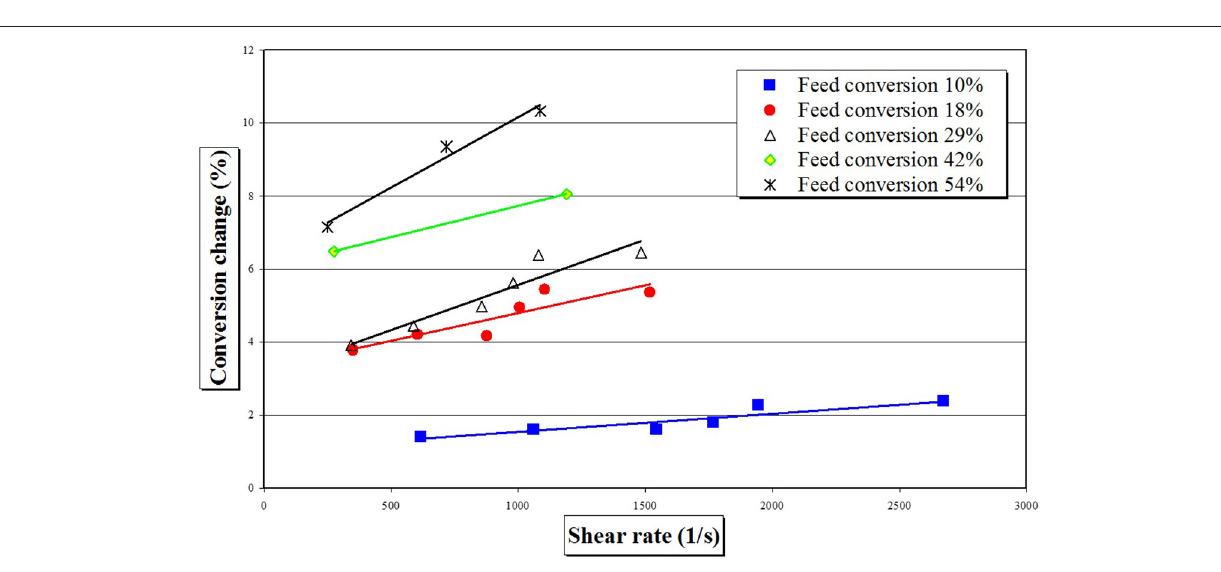
FIGURE 8 | Conversion dependency upon shear rate for free-radical styrene polymerisation after one pass in the SDR for different pre-polymer feeds at temperature of 90 ◦ C and feed flow rate of 6 cm 3 s − 1